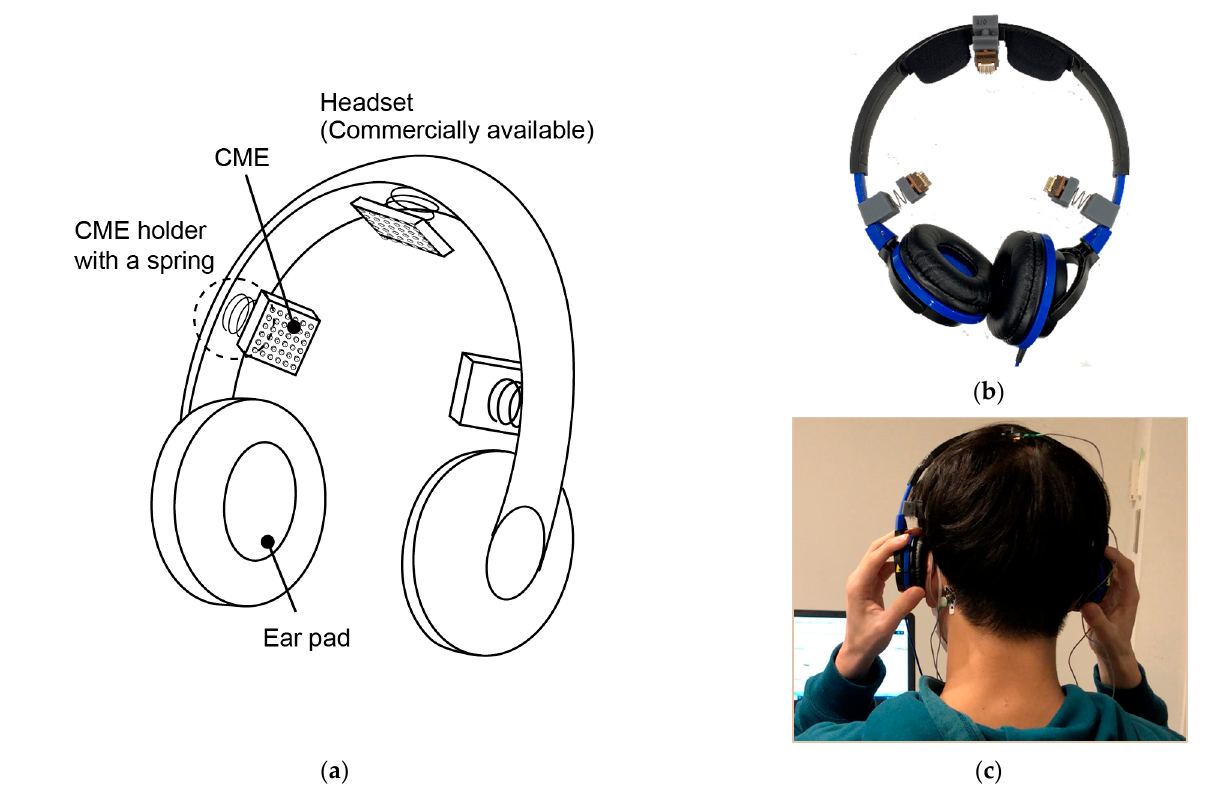
Figure 2. Proposed EEG headset. ( a ) Conceptual sketch. Three CMEs are attached to the commercially available headset with compliant springs. The springs are selected such that the perceived pressure applied by the CMEs is lower than that applied by the ear pads. Photographs of ( b ) proposed EEG headset and ( c ) user wearing EEG headset. The reference and neutral electrodes are attached to the back of the neck.